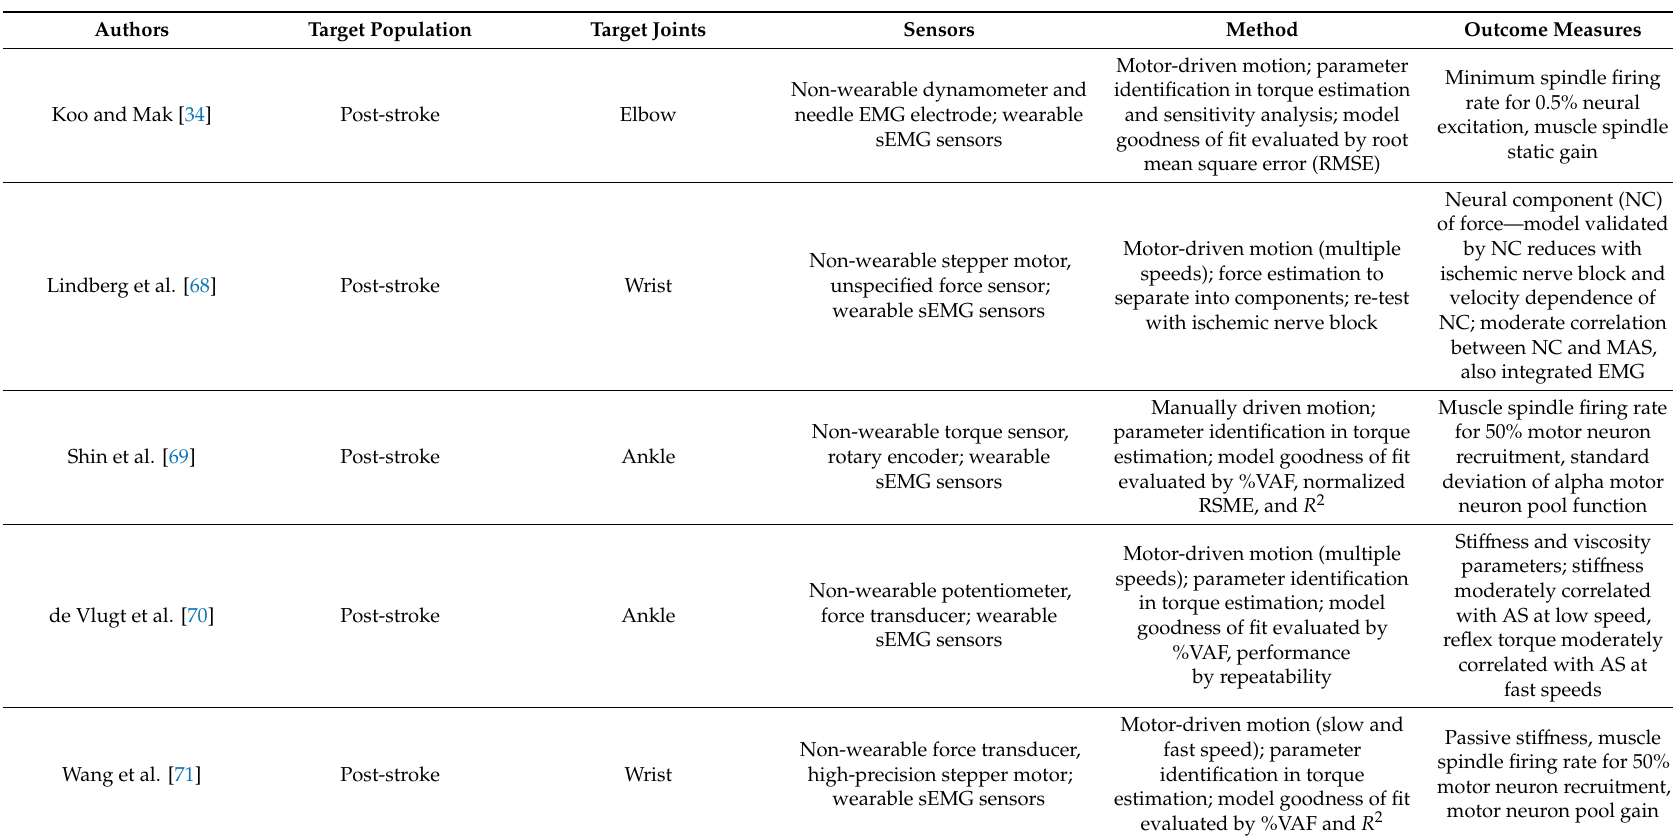
Table 3. Reviewed musculoskeletal and neural dynamics approaches to modeling